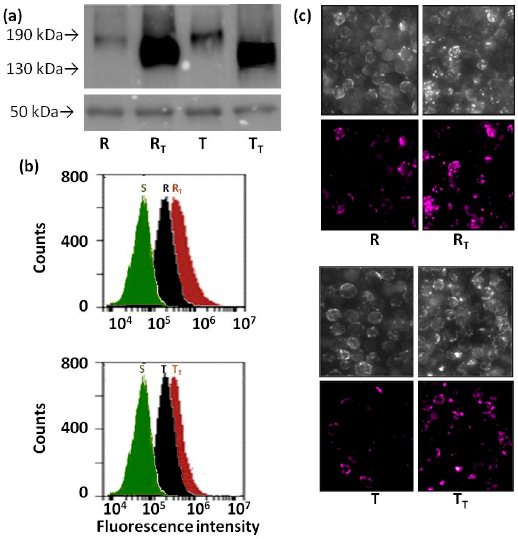
Figure 4. Ubiquitination of proteins in R and T cells passaged four times in the presence or absence of tunicamycin. Panel ( a ) detection of P-gp in immunoprecipitates obtained with rabbit polyclonal anti-ubiquitin antibody (IgG). Whole cell lysates were immunoprecipitated, and subsequently P-gp was detected using Western-blotting with a c219 antibody. The detection of rabbit IgG heavy chain (50 kDa) using an anti-rabbit antibody was included as an internal standard; Panel ( b )—detection of ubiquitinated material on the cell surface of R and T cells using a rabbit anti-ubiquitin polyclonal antibody and goat anti-rabbit antibody conjugated to Alexa Fluor 660 as primary and secondary antibodies, respectively; Panel ( c ) represents the same experiments as panel ( b ) but evaluated in InCell confocal image detection. Upper panels represent cell visualization in light microscopy mode, and the lower panels represent detection of Alexa Fluor 660 fluorescence. S represents sensitive cells cultivated four times in the absence of tunicamycin. R, T and R T , T T represent either R or T cells passaged four times in the absence or presence of tunicamycin (0.1 μ mol·dm − 3 ), respectively. Data in each panel are representative for three independent experiments.